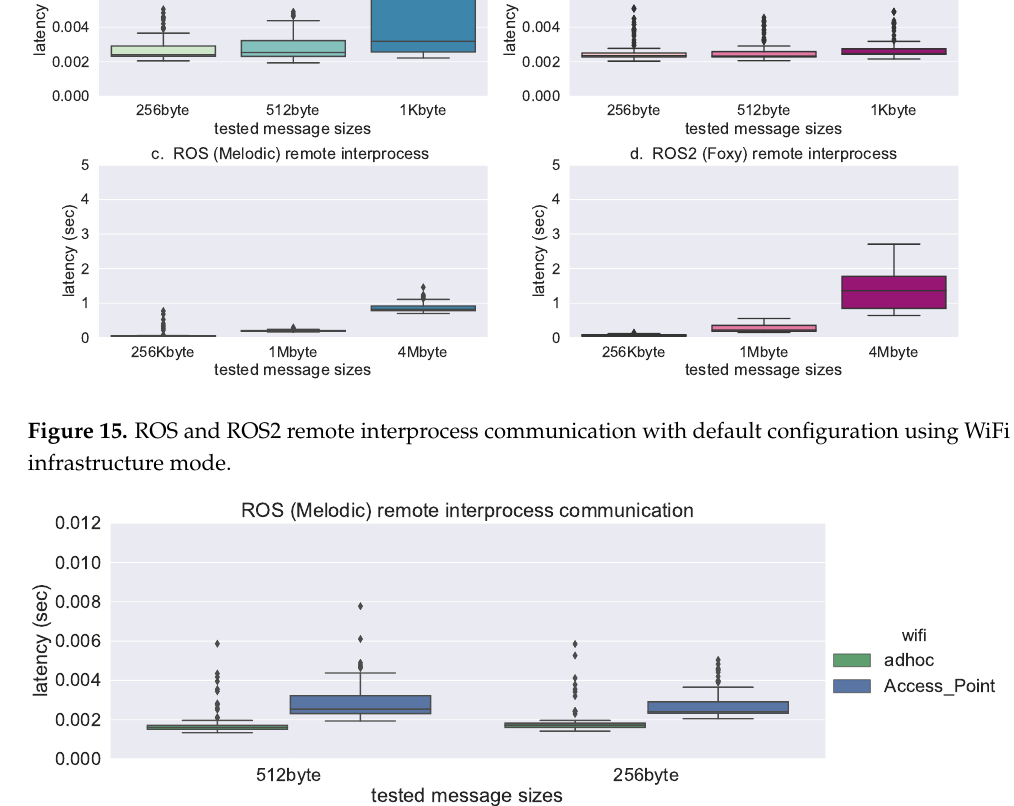
Figure 16. Remote inter-process communication using either WiFi ad-hoc mode or access point